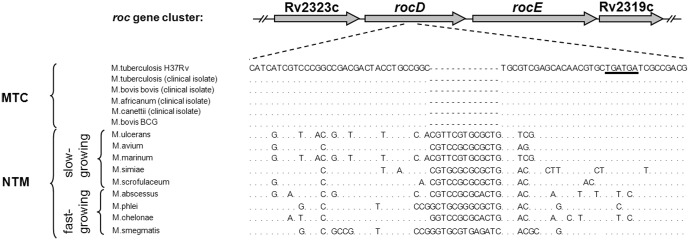
Alignment of partial rocD sequence from members of Mtb complex (MTC) and non-tuberculous mycobacteria (NTM).Besides published genome data for M. tuberculosis H37Rv, M. ulcerans, M. avium, M. marinum, and M. smegmatis, sequence data obtained from clinical isolates (M. tuberculosis, M. bovis bovis, M. africanum, and M. canettii) and from M. bovis BCG, M. simiae, M. scrofulaceum, M. abscessus, M. phlei, and M. chelonae were included. The genome sequence of Mtb H37Rv was used as a reference. The partial rocD sequence encompasses base pairs 615 to 681. Members of the Mtb complex (MTC), in contrast to non-tuberculous mycobacteria (NTM), carry a 13 bps deletion within rocD resulting in a premature stop (underlined).